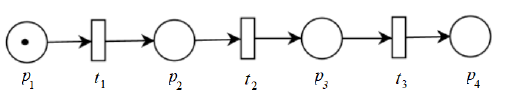
Figure 4. Quantum Petri net model of Figure 2